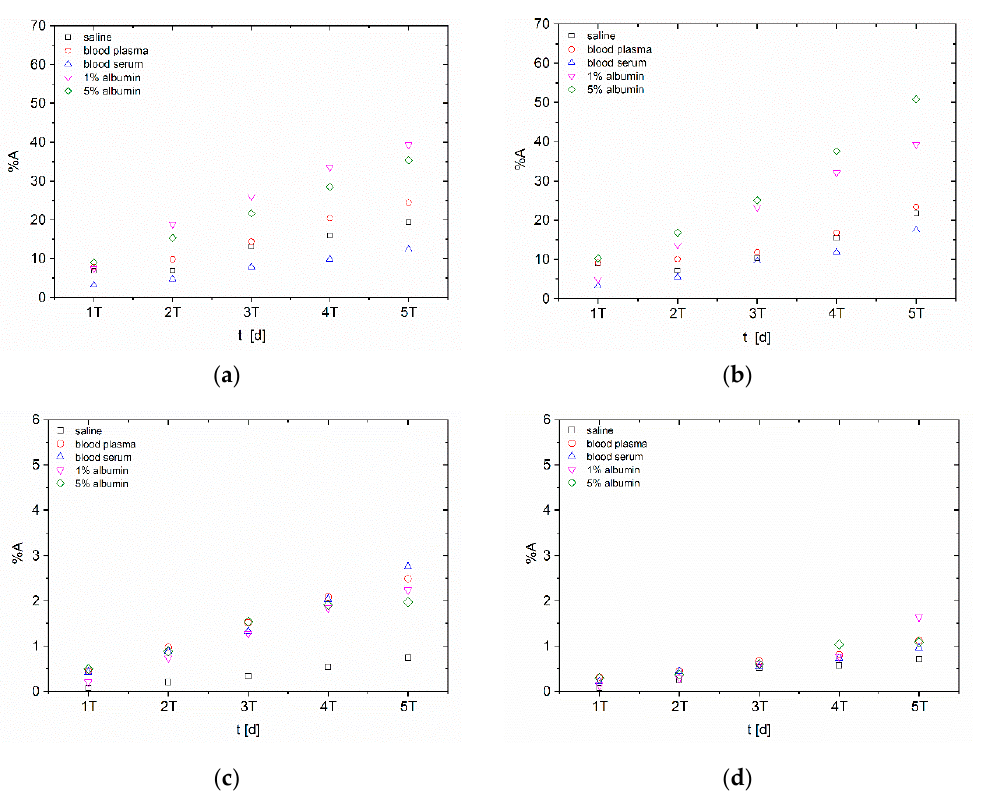
Figure 2. Long-term in vitro stability of 223 Ra-labelled nanoparticles over approx. 223 Ra half-life (T = 11 d) ( a ) surface radiolabelling of n HAp; ( b ) intrinsic radiolabelling of n HAp; ( c ) surface radiolabelling of n TiO 2 ; ( d ) intrinsic radiolabelling of n TiO 2 .